Question: Write a single sentence explaining what this figure depicts.
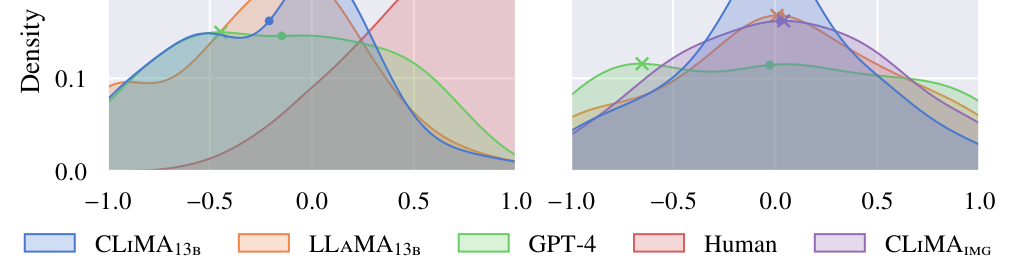
Answer: Distributions of BWS scores per model for caption and reference similarity. Scores span from -1 (poor) to 1 (excellent). The “•” markers denote expected values, and “×” signifies the mode.